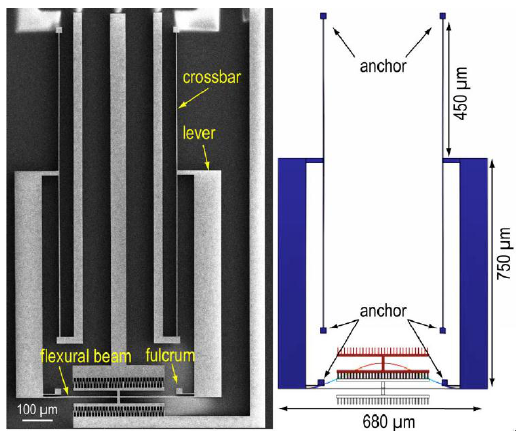
Figure 15. SEM image of magnetic field sensor (left) and its simulated vibration mode (right) [30]. Reprinted with permission from [30]. Copyright© 2015, IEEE.